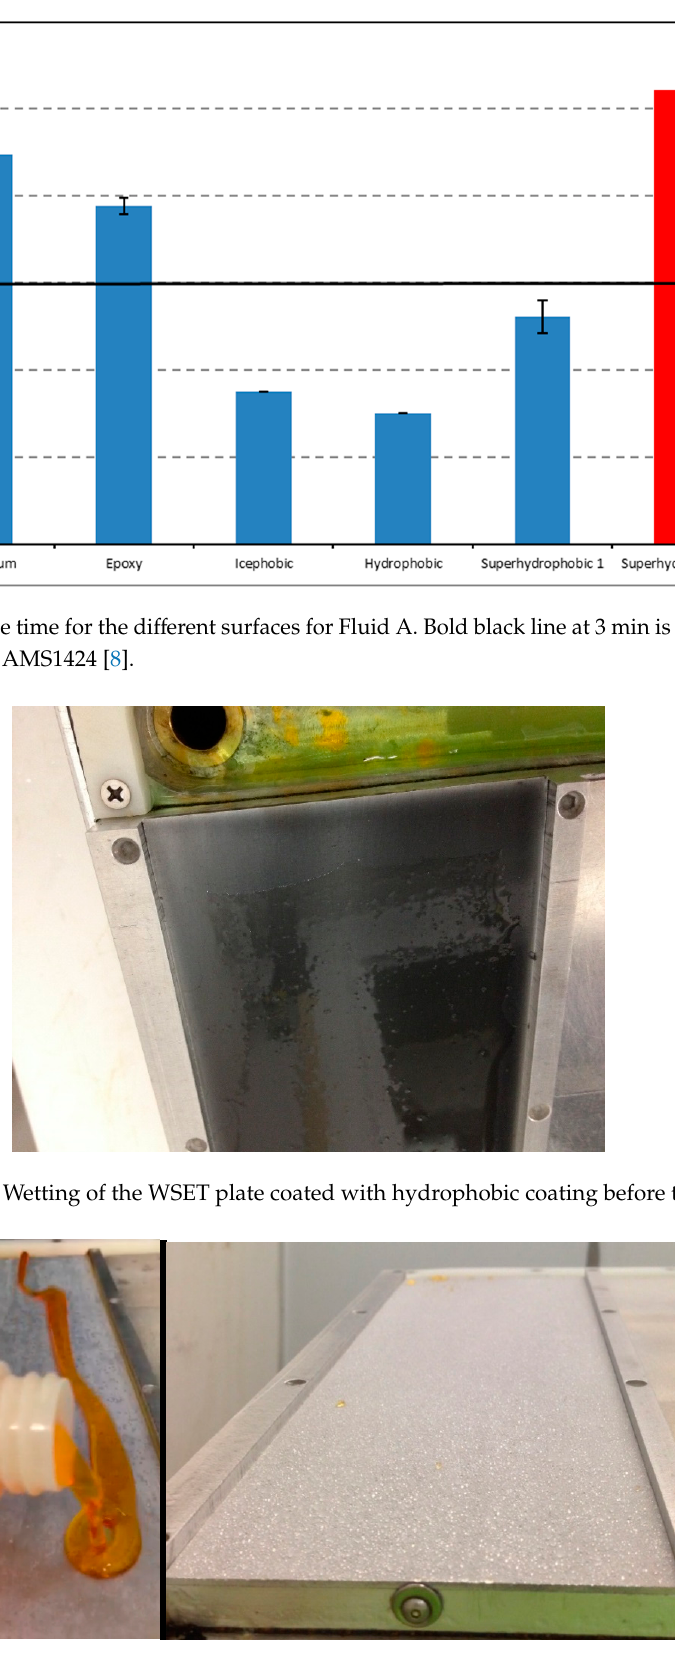
Figure 10. Pouring of Fluid A on Superhydrophobic 2.